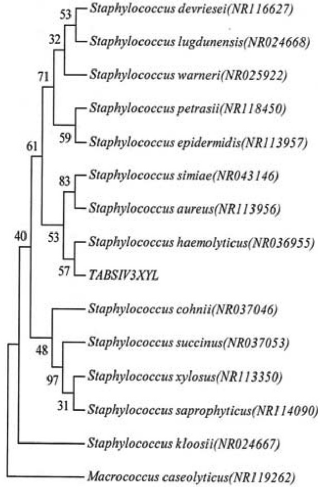
FIGURE 6 - Neighbor-joining tree based on 16S rRNA (1822) sequences showing the relationship between unknown isolate TABSIV2MAC and other closely related species of the genus Bacillus .